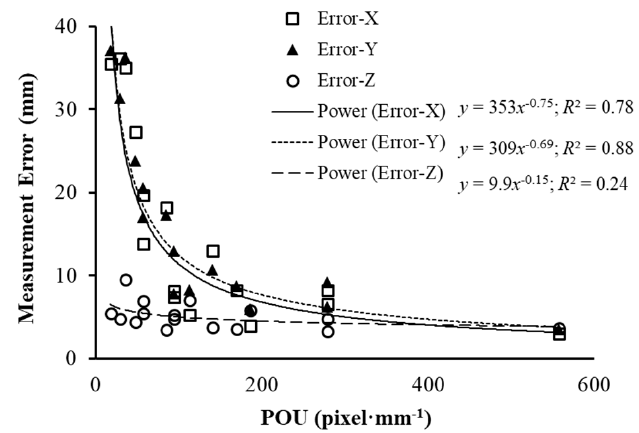
Figure 7. Regression functions between average measurement errors of three shapes and POU in three dimensions.